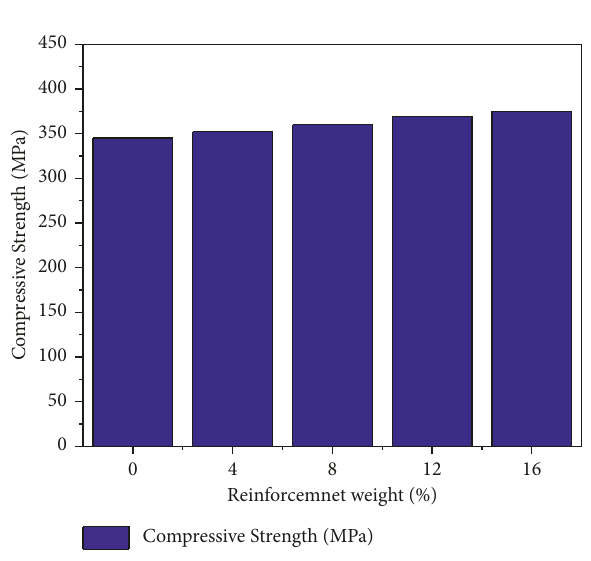
Figure 3: Compression strength.